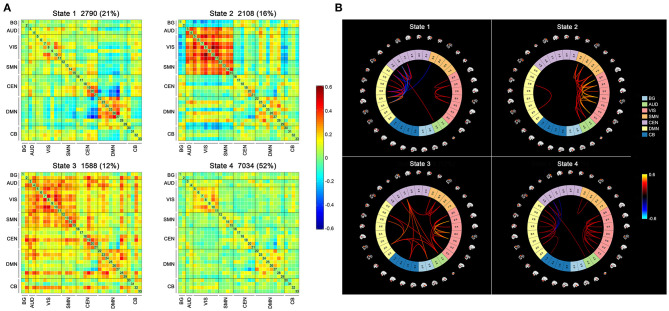
The four states identified by k-means clustering analysis and the corresponding cluster centroids. The total number and percentage of the reoccurrence times of each state are listed above each cluster (A), and the 5% strongest connections of each state are shown (B). BG, basal ganglia; AUD, auditory; VIS, visual; SMN, sensorimotor; CEN, cognitive executive; DMN, default mode; CB, cerebellar.